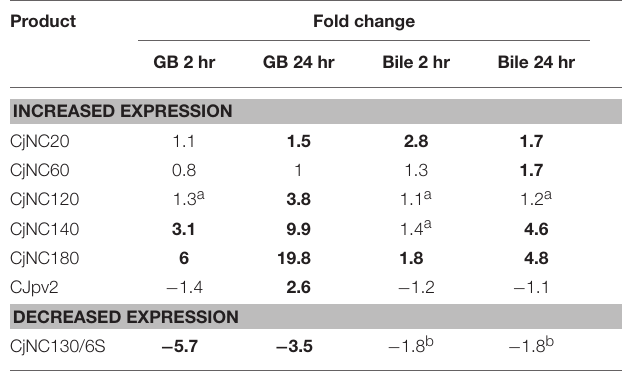
TABLE 6 | Differential expression observed under each condition of previously validated non-coding RNAs ( Dugar et al.,